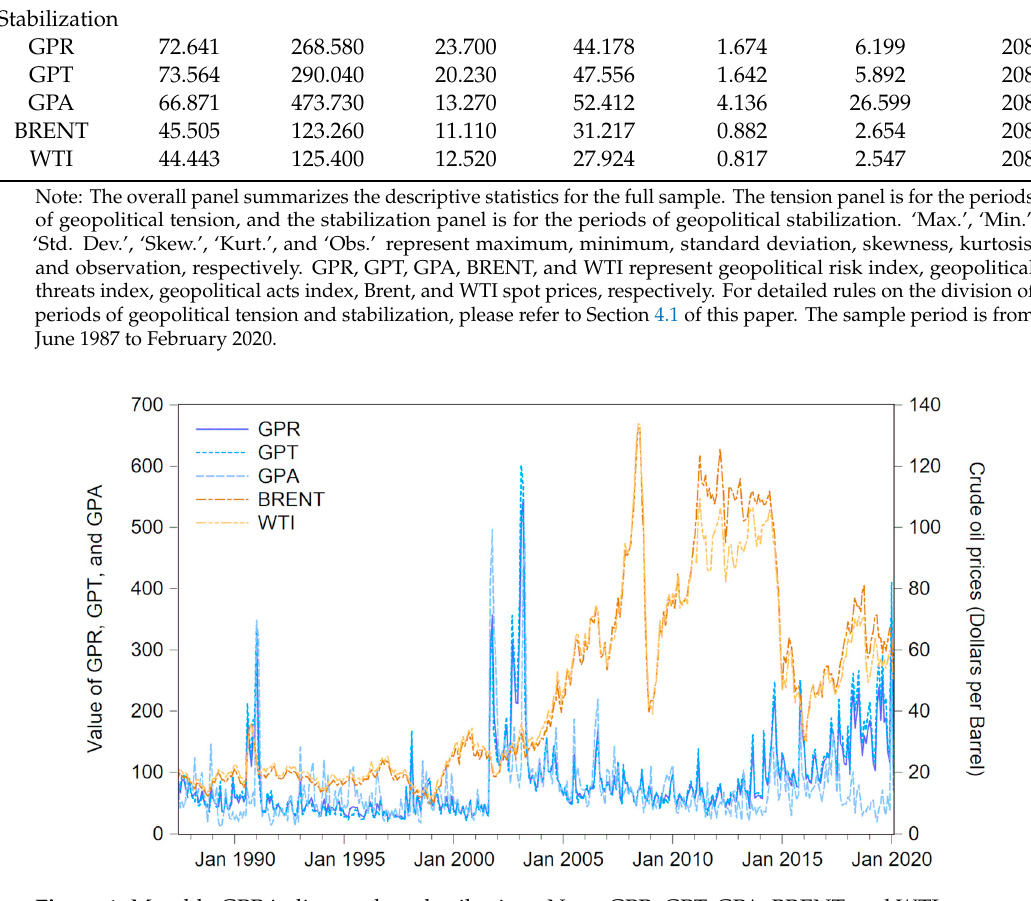
Figure 1. Monthly GPR indices and crude oil prices. Note: GPR, GPT, GPA, BRENT, and WTI represent geopolitical risk index, geopolitical threats index, geopolitical acts index, Brent, and WTI spot prices, respectively. The sample period is from June 1987 to February 2020.